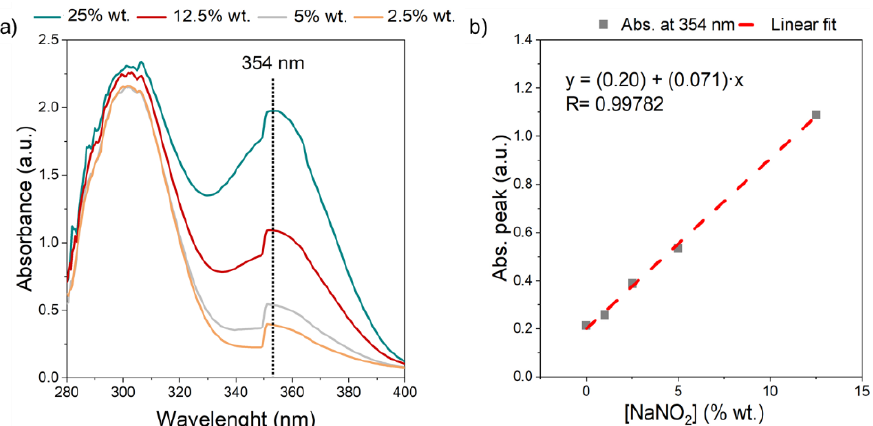
Figure 3. UV-vis spectra of 0.3M sodium nitrate-nitrite solutions: ( a ) evolution of nitrite peak with the concentration of NaNO 2 , from 2.5 to 25% wt. in NaNO 3 solution, ( b ) linear relationship between light absorption and the concentration of nitrites at a wavelength of 354 nm.